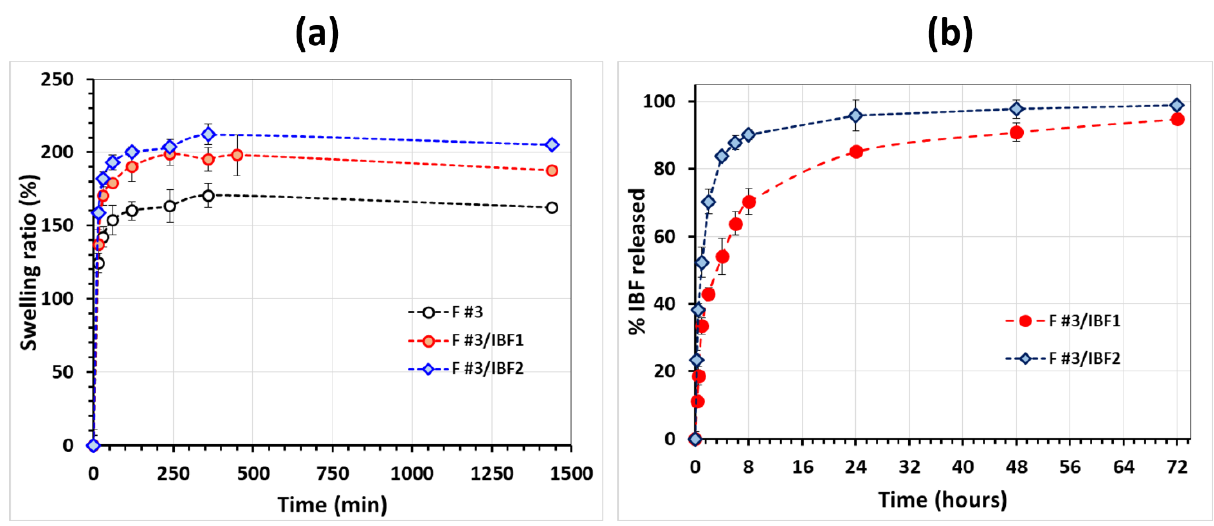
Figure 9. Swelling ratio ( a ) and release profiles of ibuprofen ( b ) of/from composite PVA/OxCS-Ag films with two different drug loading capacities in phosphate buffer at pH 6.8 and 37 °C. Results are expressed as mean ± standard deviations (n = 3).